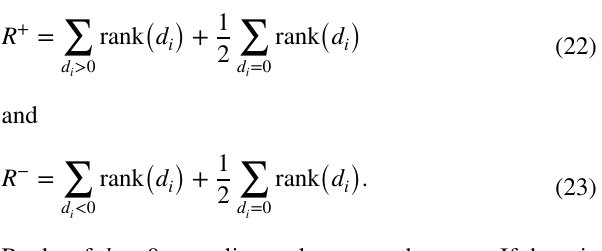
Bold values indicate the best results obtained